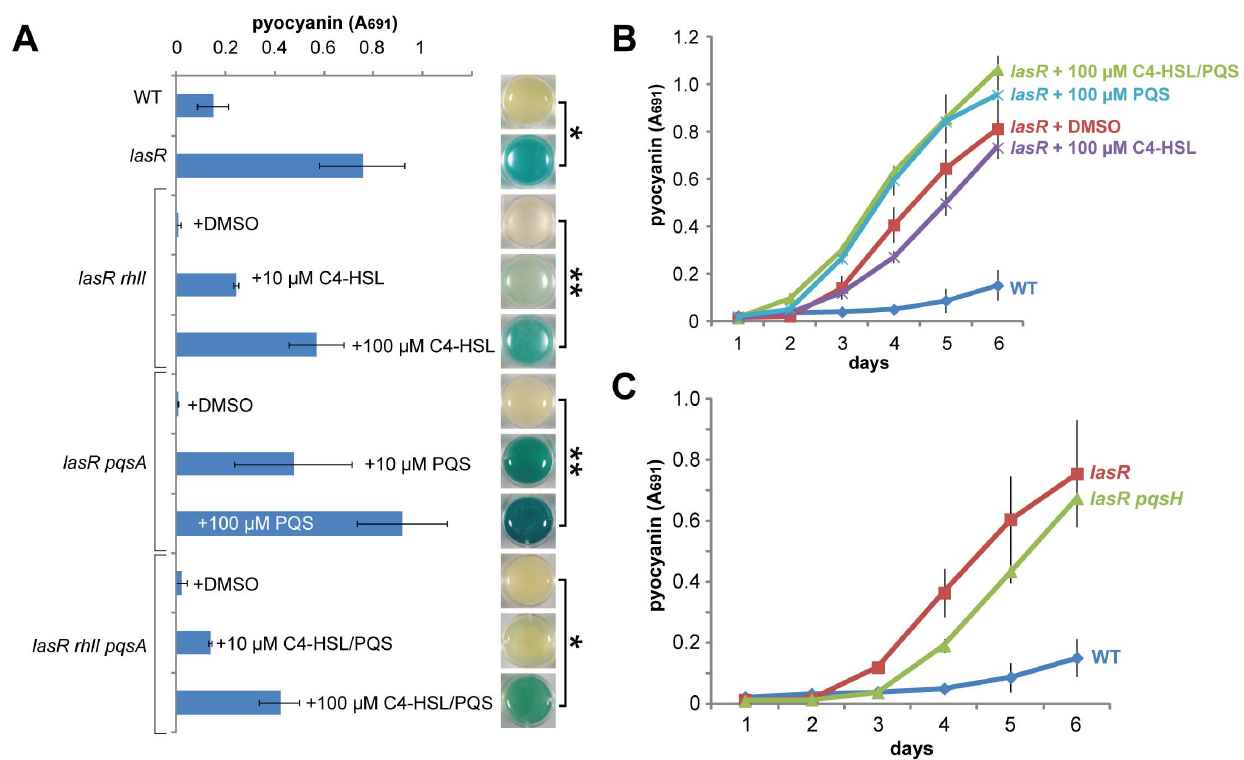
Figure 3. Pyocyanin production by stationary-phase lasR mutant cells requires Rhl and quinolone signaling. A. Pyocyanin quantification in the listed strains with or without the listed signaling molecules after 6 days of LB static culture at 25 u C. The images to the right of the bar graph show the appearance of representative cultures. *, p , 0.005; **, p , 0.001. The differences between lasR and the 100 m M-complemented autoinducer-negative samples were not significant (0.04 , p , 0.33). B. Pyocyanin quantification in static LB cultures of the listed strains and conditions at 25 u C. C. Pyocyanin quantification in static LB cultures of the listed strains at 25 u C. All plots show the mean 6 standard deviation of 3 biological replicates.